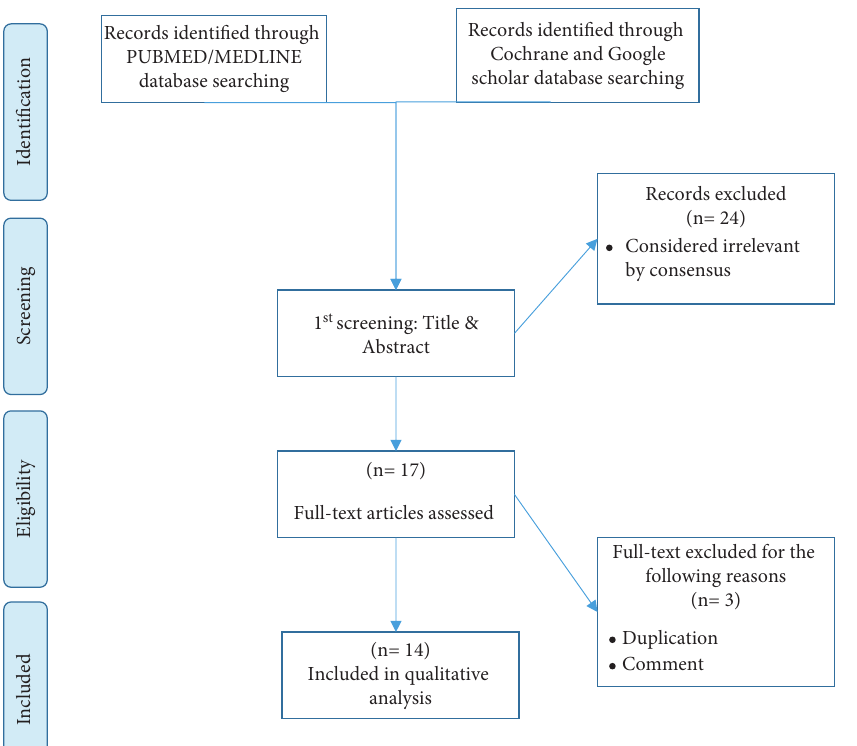
Figure 1: Flowcharts for the studies were identified, displayed, and included in the